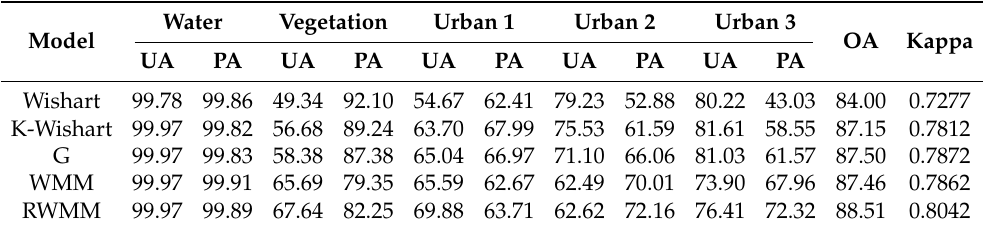
Table 2. The ML-Based Classification Accuracy (%) Comparison of Five Models on the San Francisco Region.